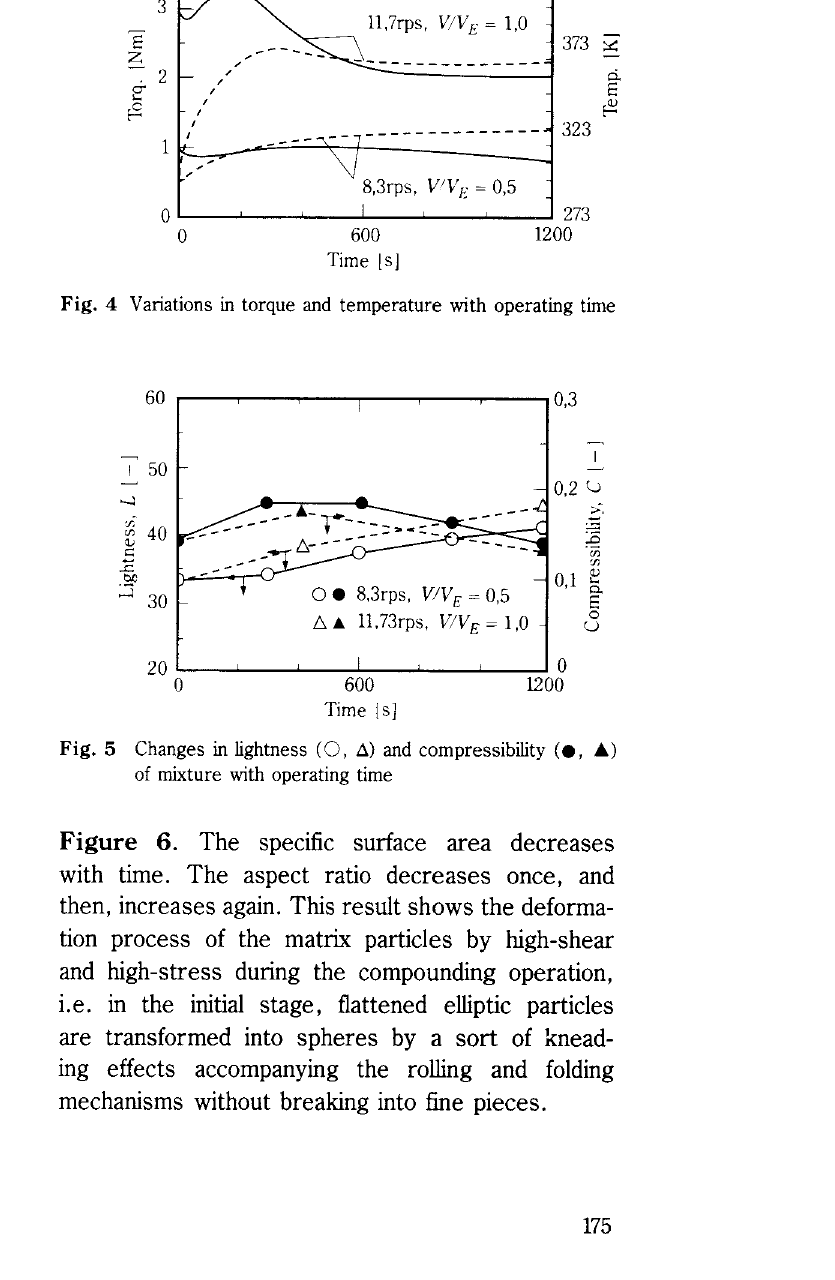
Fig. 3 Relationship between torque and rotational speed